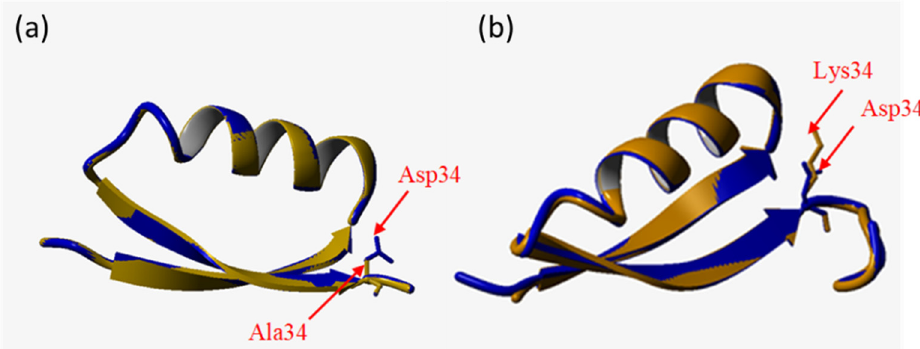
Figure 4. Comparison of the structure of coenzyme-binding centers of mutant GAPDH and the wild- type protein. ( a ) replacement of D34A: fragment of 1 to 40 amino acid residues. In blue—wild type, in yellow—mutant protein. ( b ) replacement of D34K: fragment of 1 to 40 amino acid residues. In blue—wild type, in yellow—mutant protein.